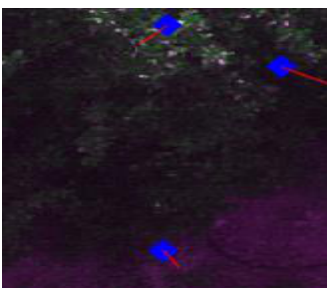
Figure 8. miss-registration error vecor in data set 3, with 20x magnification and the points are presented in blue and the error vector in red lines .